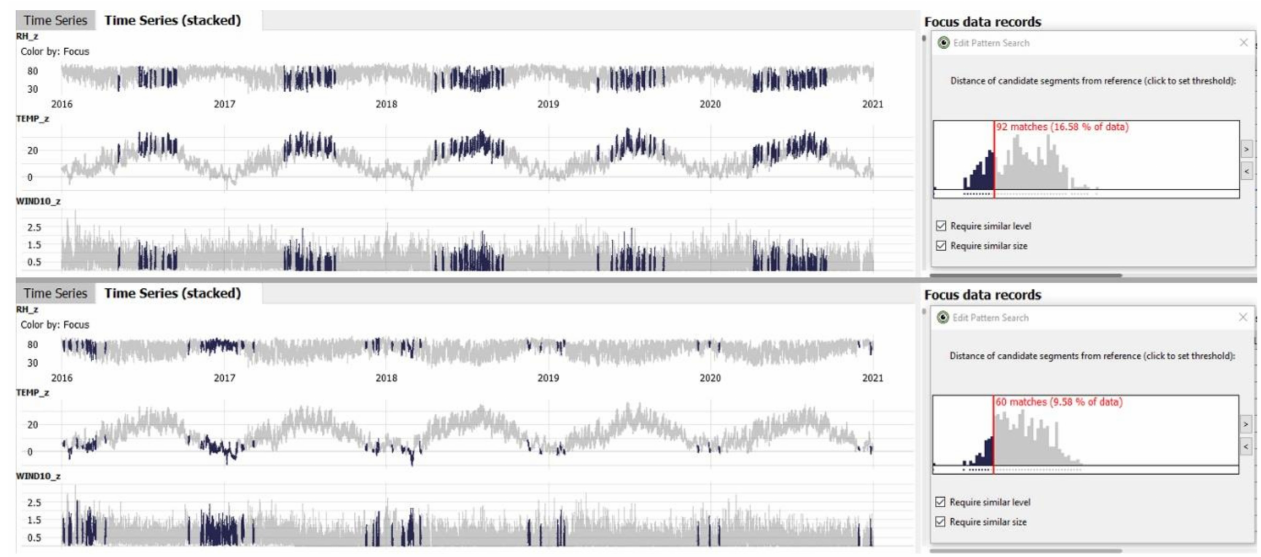
Figure 11. Multivariate pattern analysis of paired parameters for Zürich: hot events ( above ), cold events ( below